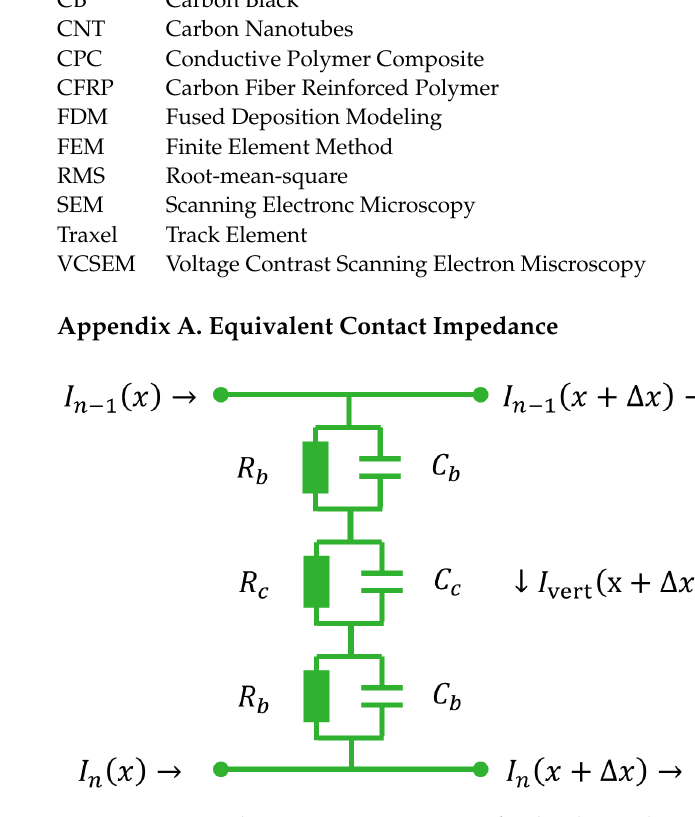
Figure A1. Equivalent circuit representation for the electrical contact properties c combined with the vertical bulk properties b of a slice of two neighbouring traxels of ∆ x